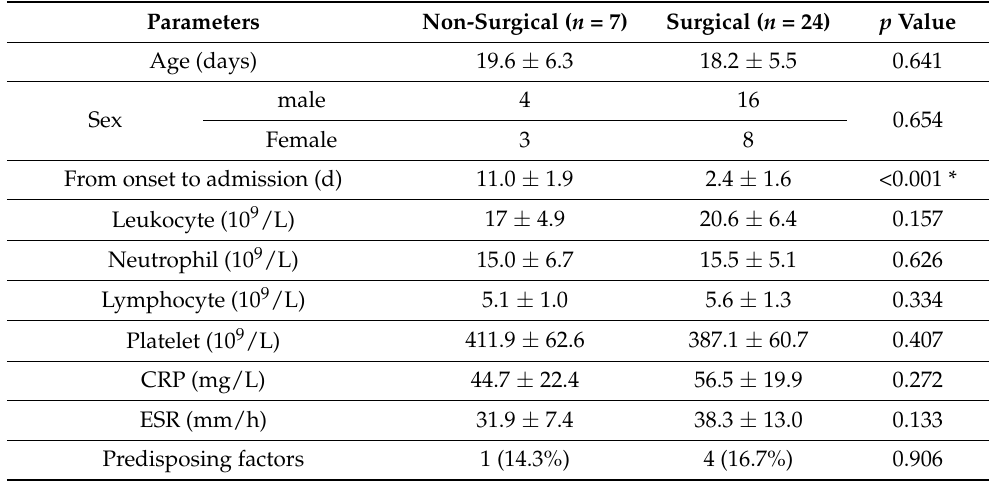
Table 1. Characteristics of the